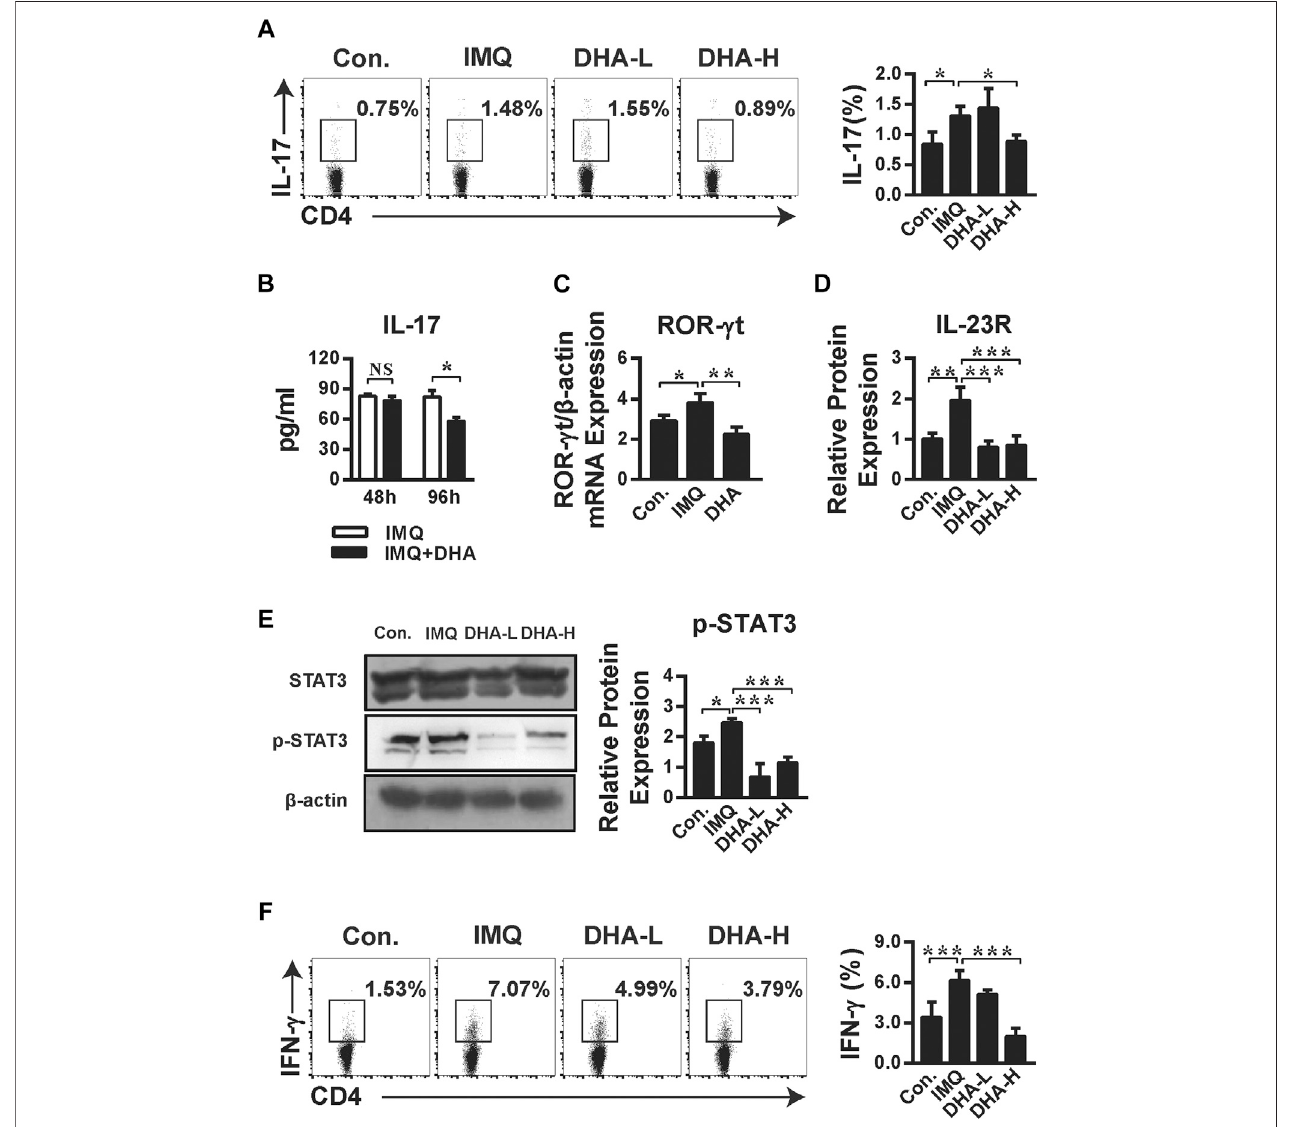
FIGURE 6 | DHA restrained psoriasis dependent on IL-23/Th17 axis. (A) The frequency of IL-17 + CD4 + T cells was analyzed by fl ow cytometry (* p < 0.05). (B,C) Splenic single cell suspensions were stimulated as described in the Materials and Methods. (B) The concentration of IL-17 from puri fi ed CD4 + T cells in the culture supernatant was measured by ELISA. Statistical analysis was carried out using unpaired t -test (* p (cid:2) 0.0304, NS. Not signi fi cant, n (cid:2) 5 – 6). (C) ROR- γ t mRNA level from Th17 cells was detected by RT-PCR (* p (cid:2) 0.0448, ** p (cid:2) 0.0038). (D) IL-23R mRNA levels in skin sections (30 mg) were analyzed by RT-PCR (** p (cid:2) 0.0026, *** p < 0.001). (E) STAT3 phosphorylation in splenocytes from control, IMQ-, and DHA-treated mice was assessed by western blotting (* p (cid:2) 0.0396, *** p < 0.001). (F) IFN- γ production by CD4 + T cells from spleens was measured by fl ow cytometric analysis (*** p < 0.001). Statistical analysis was carried out using One-way ANOVA analysis of variance followed by Dunnett ’ s test (A, C – F; n (cid:2) 4 – 6).